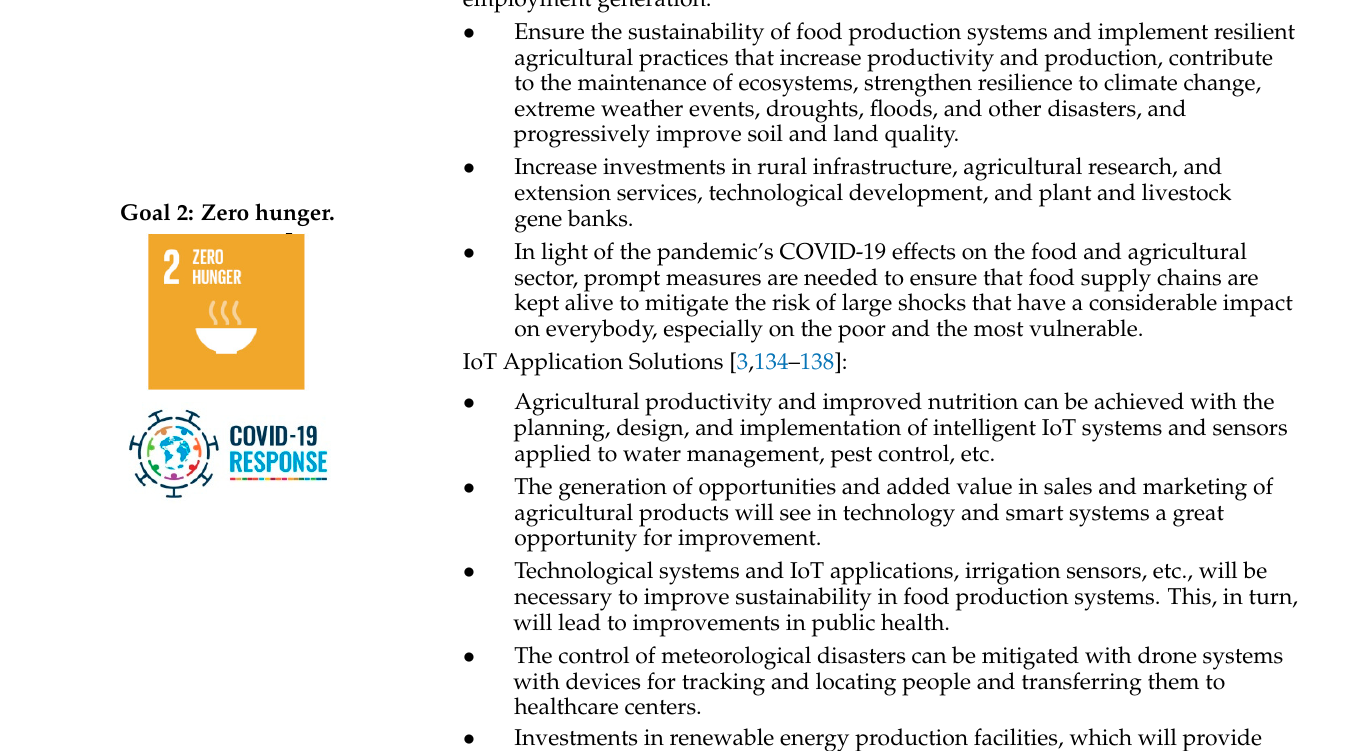
Table 5. Cont. Table 5. Impact of the Sustainable Development Goals on IoT applications for improving health and the environment. SDGs Targets Goals and Application to IoT Systems